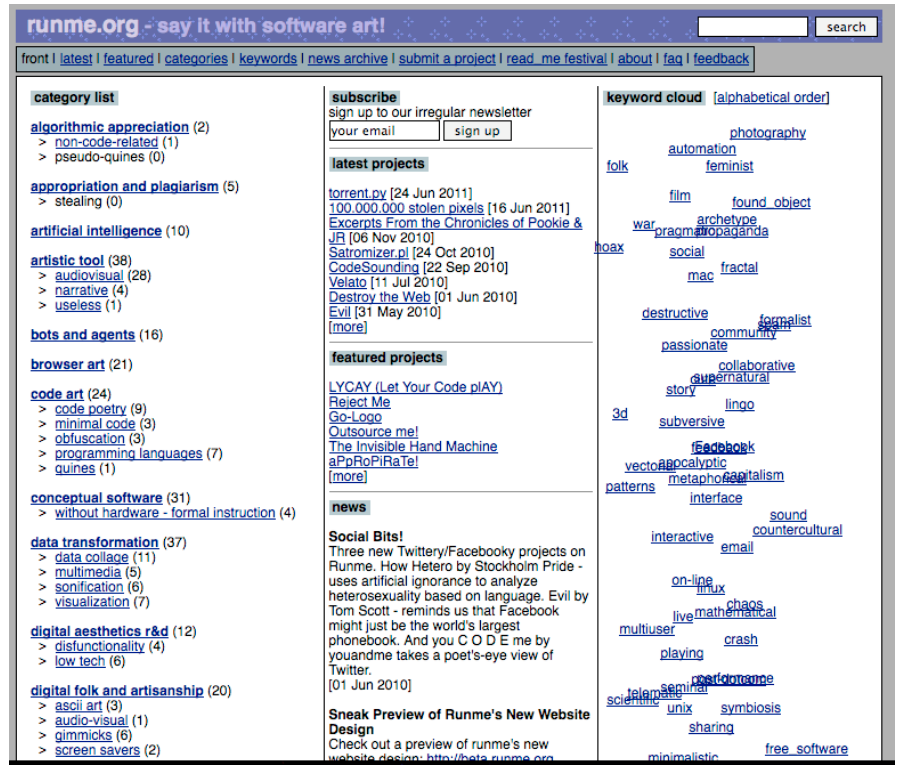
Figure 5. Runme , 2003. Screenshot of index page, 2015. @ Runme, 2019.